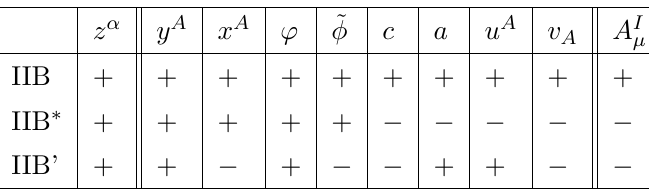
Table 12 . Signs of the kinetic terms for scalar and vector fields resulting from type-IIB CY3 compactifications. A + indicates a standard kinetic term. The fields z α are the vector multiplet